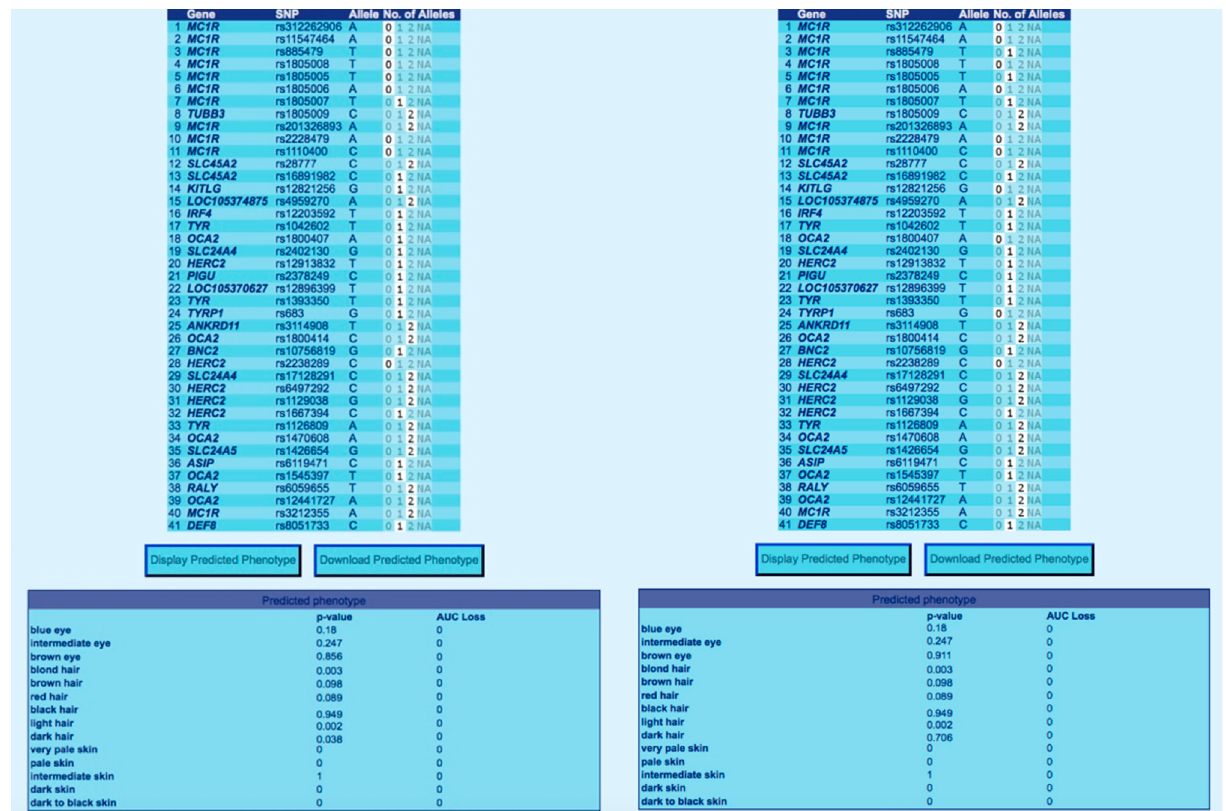
Figure 3. Phenotype and trait prediction shown by samples I7, shown on the left, and I10, shown on the right. Charts taken from entering data in the tool available on the website https://HIrisPlex.erasmusmc.nl (last accessed on 17 February 2023). In the figure, “0” indicates if the input allele is not present; “1” indicates the presence of heterozygosity; and “2” shows the presence of the homozygous input allele; “NA” shows missing SNP.